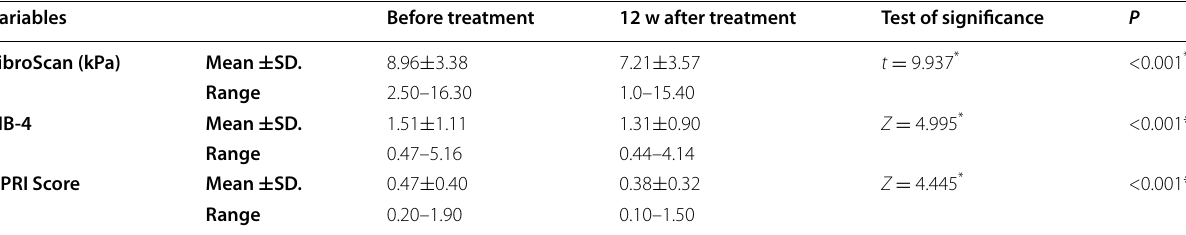
t paired t -test, Z Wilcoxon signed-ranks test, *significant Table 3 Comparison between patients before and 12 weeks after EOT regarding FibroScan stages Fibrosis